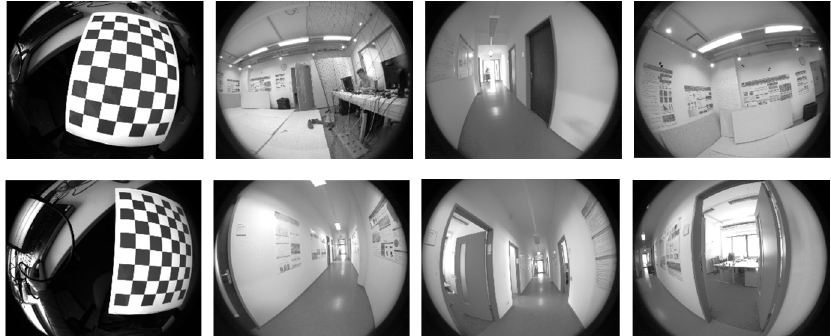
Figure 6. The fisheye images from the TUM data set.